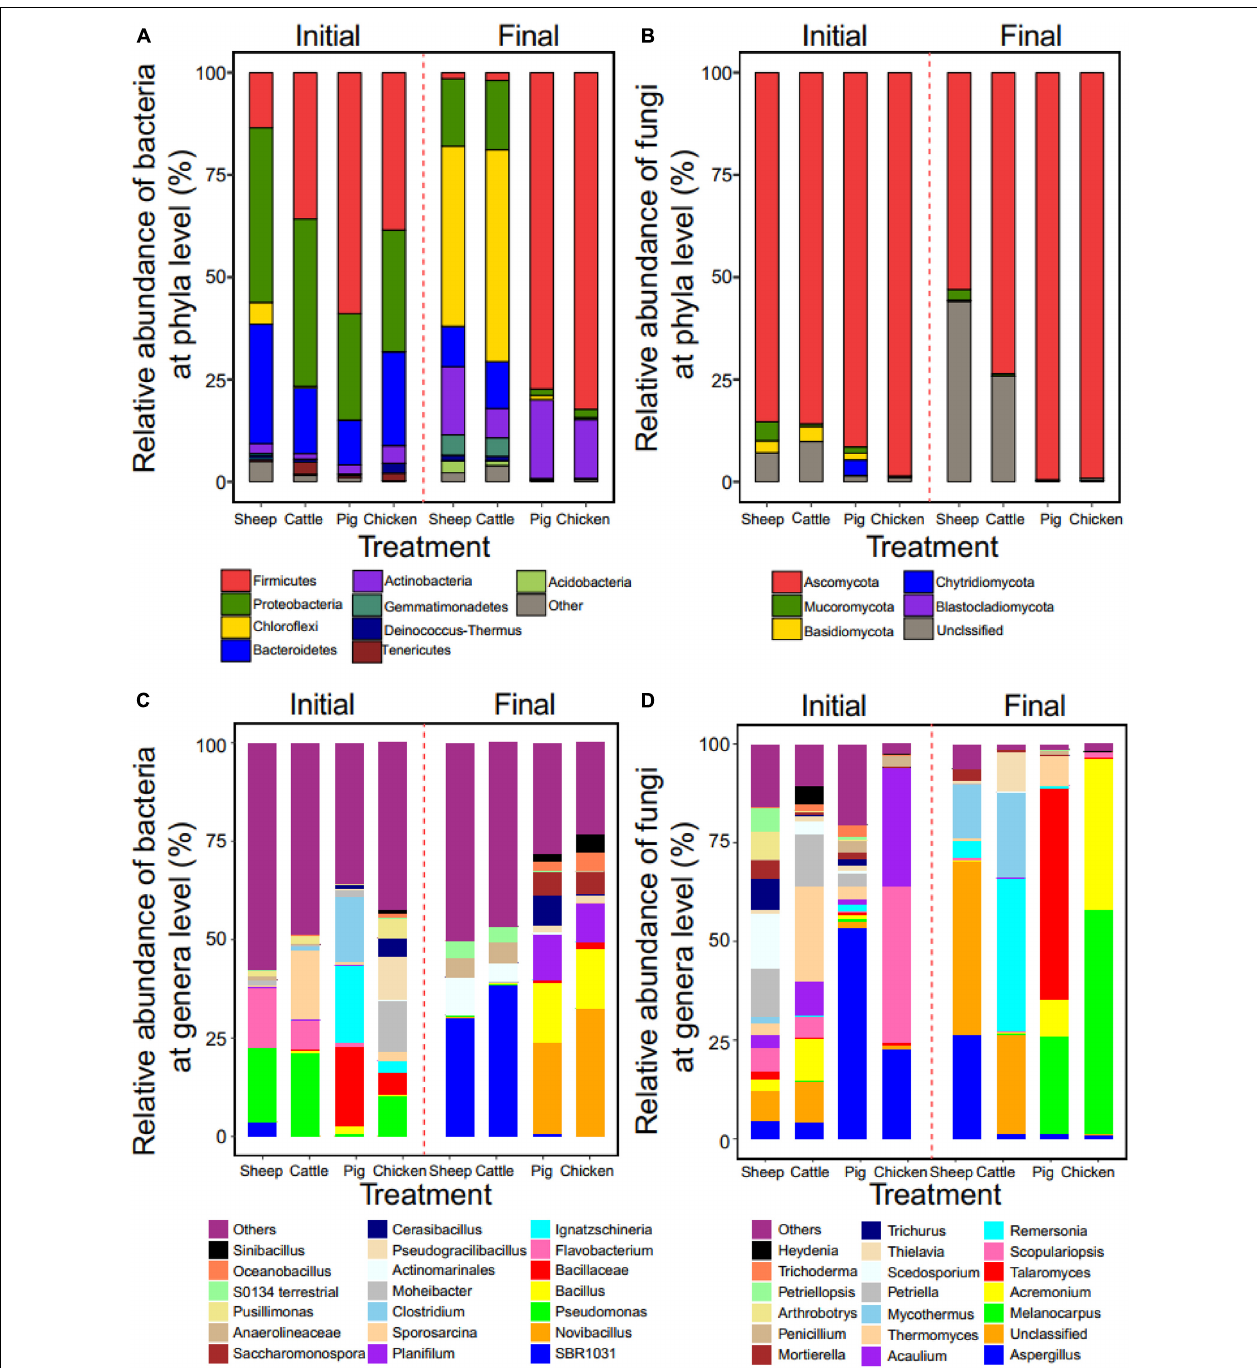
FIGURE 3 | Effect of composting on manure compost metataxonomy at phyla and genera levels. The relative abundance of the dominant bacterial (A) and fungal (B) taxa at the phyla level in all manure compost treatments at the initial and final phases of the composting (based on OTUs of top 9 phyla). The relative abundance of the dominant bacterial (C) and fungal (D) taxa at the genera level (top 20 genera included). In all panels, colors correspond to relative abundance of different phyla or genera. N = 3 for each type of manure compost.